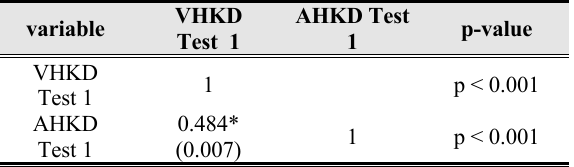
Correlation between VHKD and AHKD (Test 1)